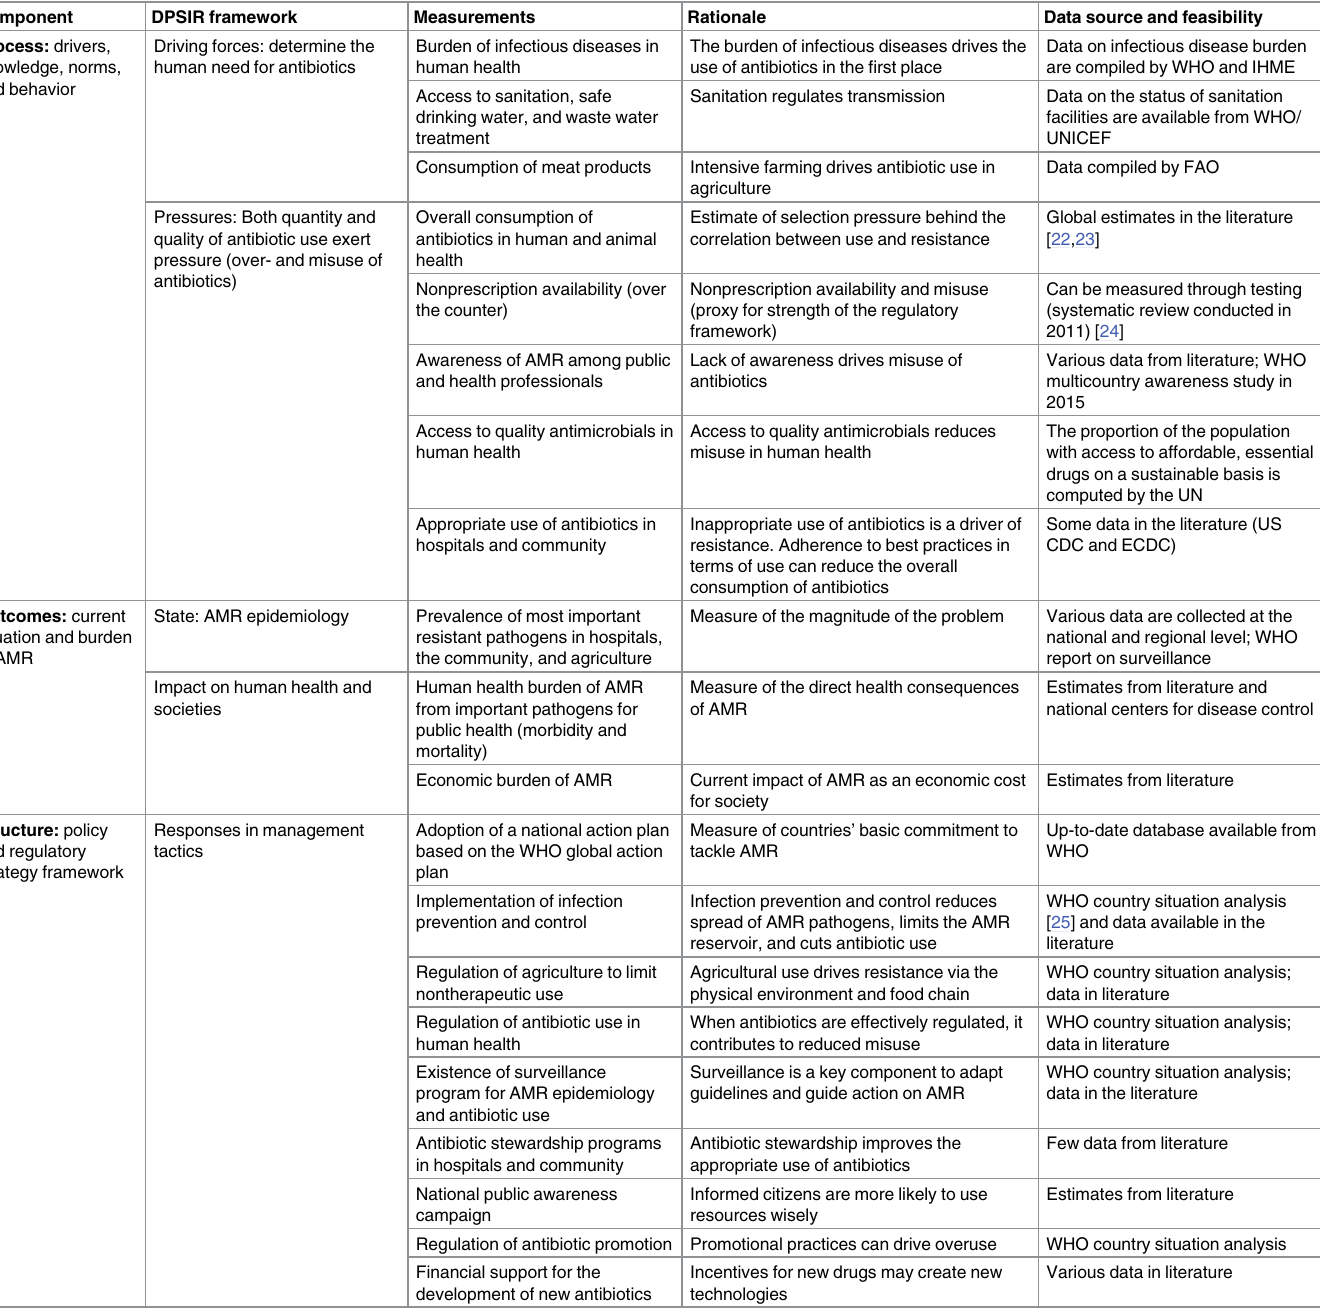
Table 1. Candidate measurements to be considered as part of monitoring AMR and its